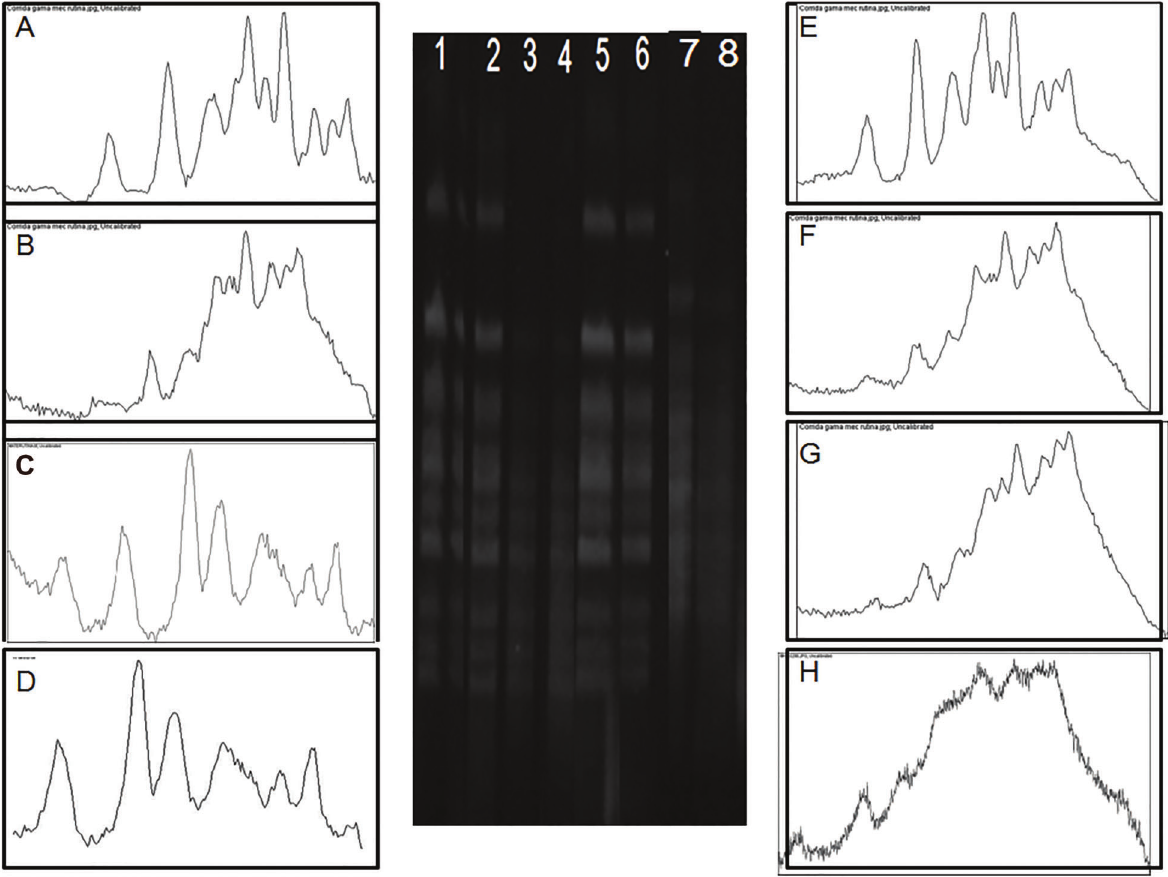
Figure 7. Densitograms corresponding to the SJR751 strain ( A – D ) and sml1/mec1 strain ( E – H ) shown in the 1 – 8 middle panel photograph, respectively. Comparative absorbance (Y-axis) as a function of distance (X-axis). A and E : control sample; B and F : g irradiated sample; C and G : g + rutin; D and H : g + Ilex paraguariensis sample. Middle panel: Chromosomal DNA gel photograph of control and treated cell samples after pulsed fi eld